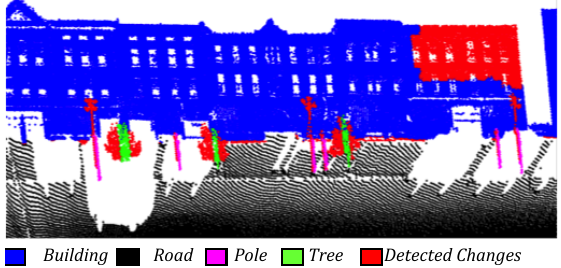
Figure 6: The different changes detected in one of the urban scene are presented in red. These changes were due to demol- of bushes/trees in the scene.